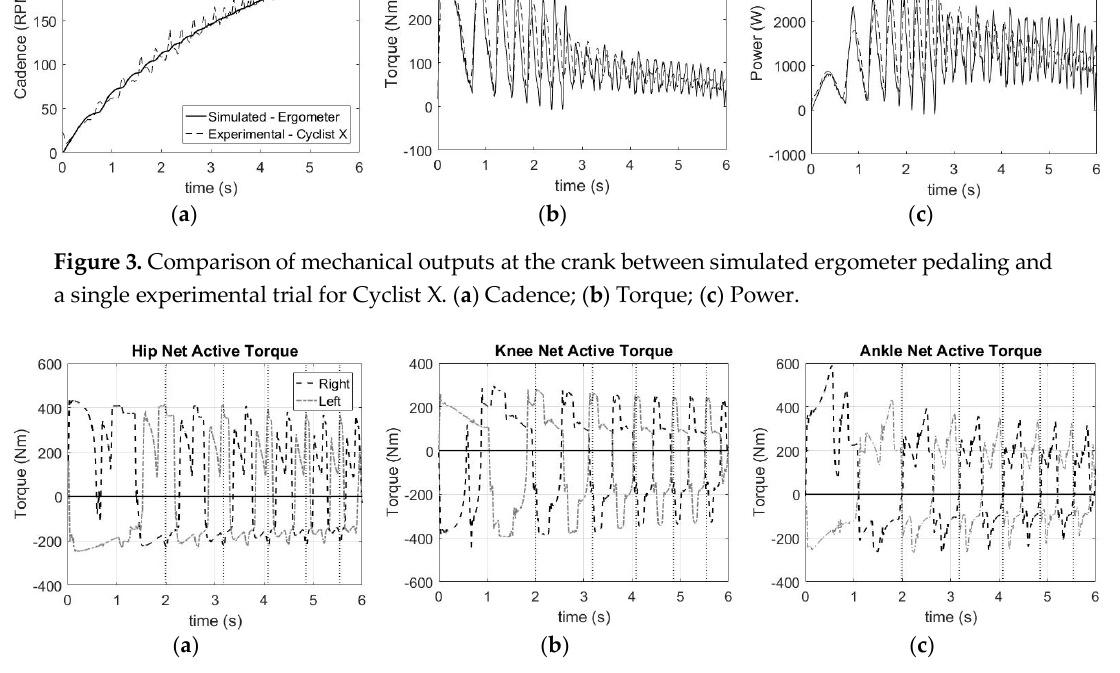
Figure 4. Net active torque at each joint over the course of the simulation using the bicycle model. Vertical dotted lines represent the beginning of each pedal stroke ( a ) Hip—positive is extension; ( b ) Knee—positive is flexion; ( c ) Ankle—positive is plantar